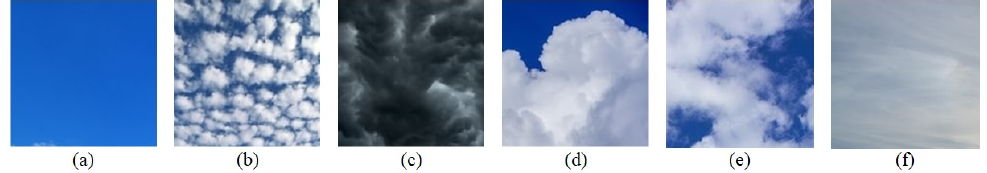
Figure 4. Six categories of cloud/sky images in the Cloud-ImVN 1.0 dataset: ( a ) clear blue sky, ( b ) patterned clouds, ( c ) thick dark clouds, ( d ) thick white clouds, ( e ) thin white clouds, ( f ) cloud